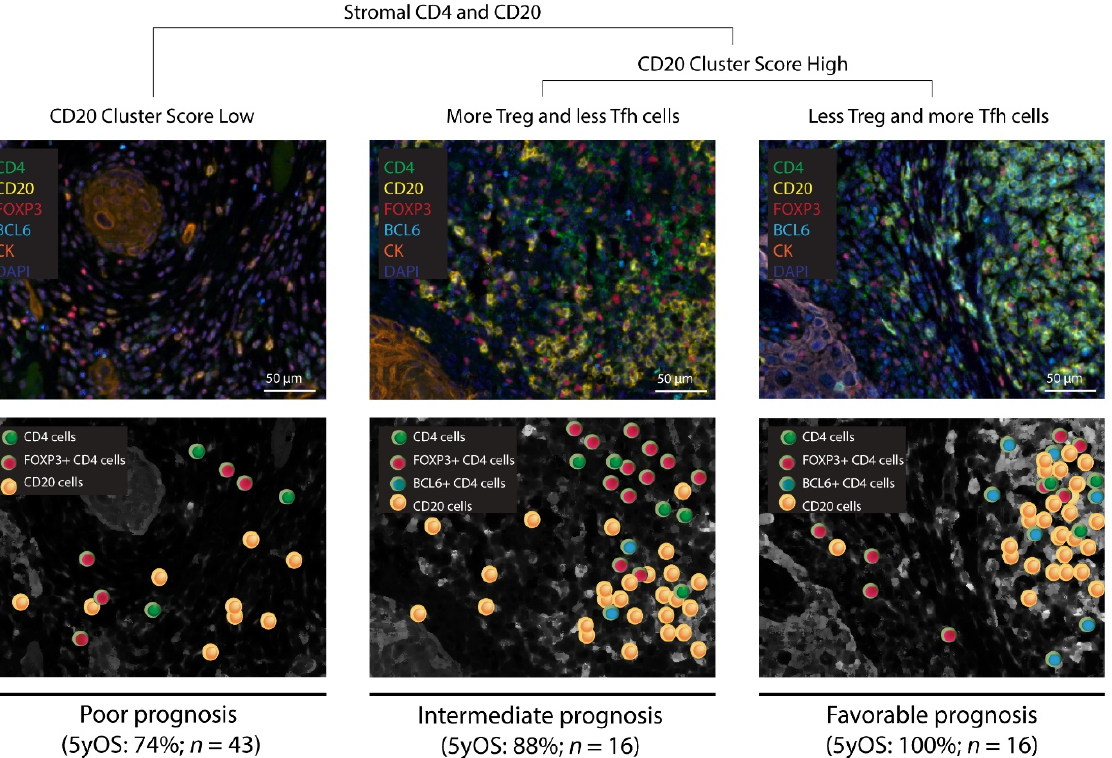
Figure 5. The prognostic value of the CD20 Cluster Score according to the relative abundance of Tfh and Treg cells. Three scenarios for patients with early OSCC showing different CD20 cluster scores and abundances of Tfh cells (BCL6+ and CD4+) relative to Treg cells (FOXP3+ and CD4+). Each scenario is accompanied by a representative multispectral image of a tumor with CD4 T cell or CD20 B cell subsets being highlighted. 5yOS, 5-year overall survival rate.